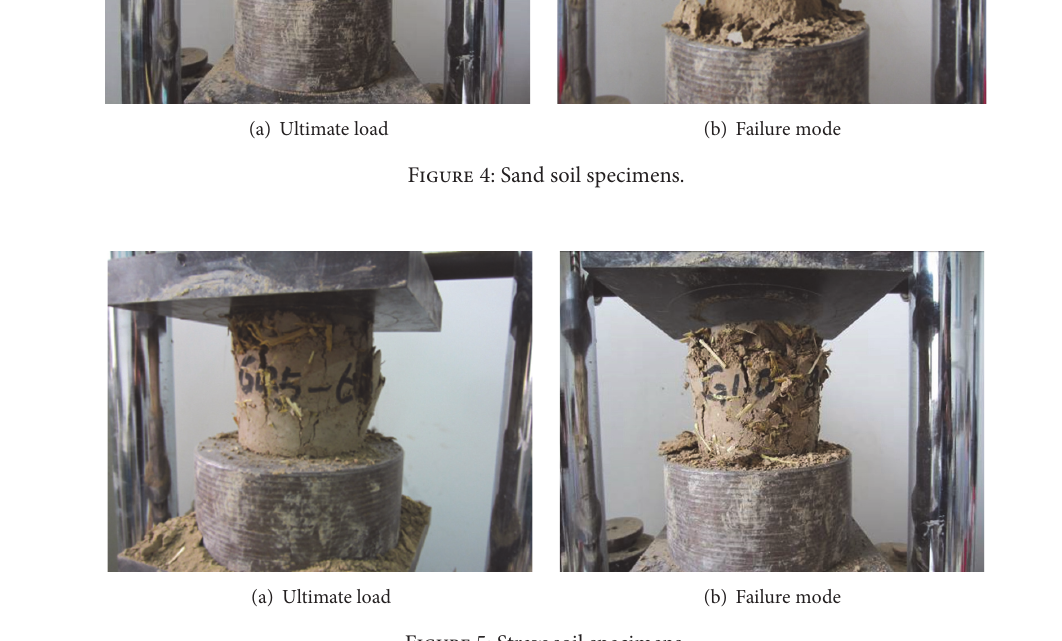
Figure 5: Straw soil specimens.